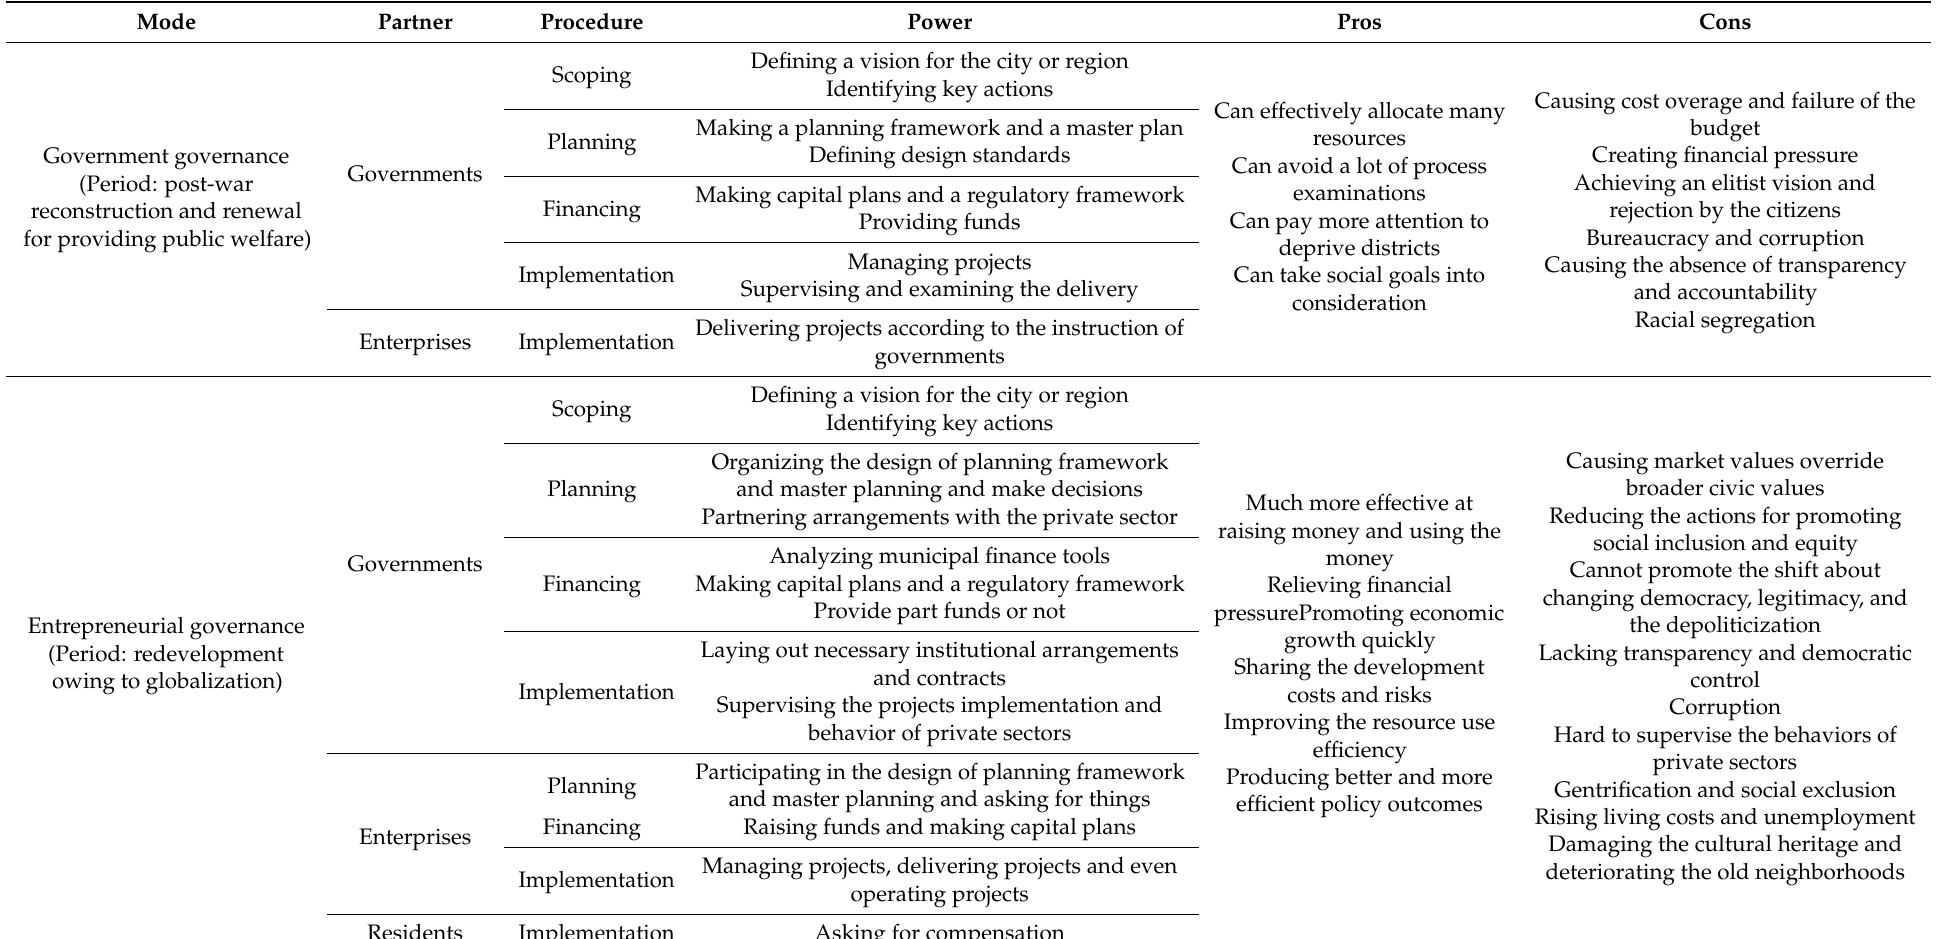
Table 2. The signature elements (partner, procedure, power) and pros and cons of different modes of